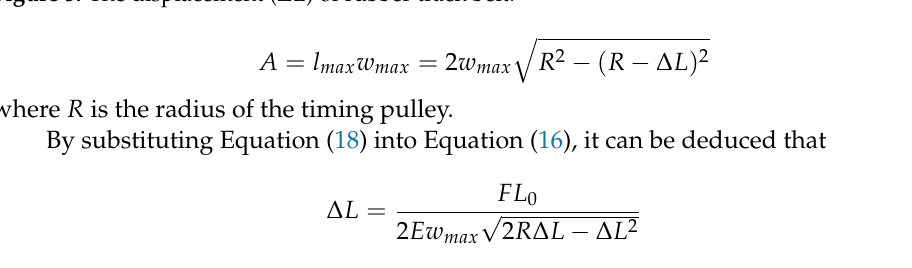
Figure 5. The displacement ( ∆ L ) of rubber track belt.